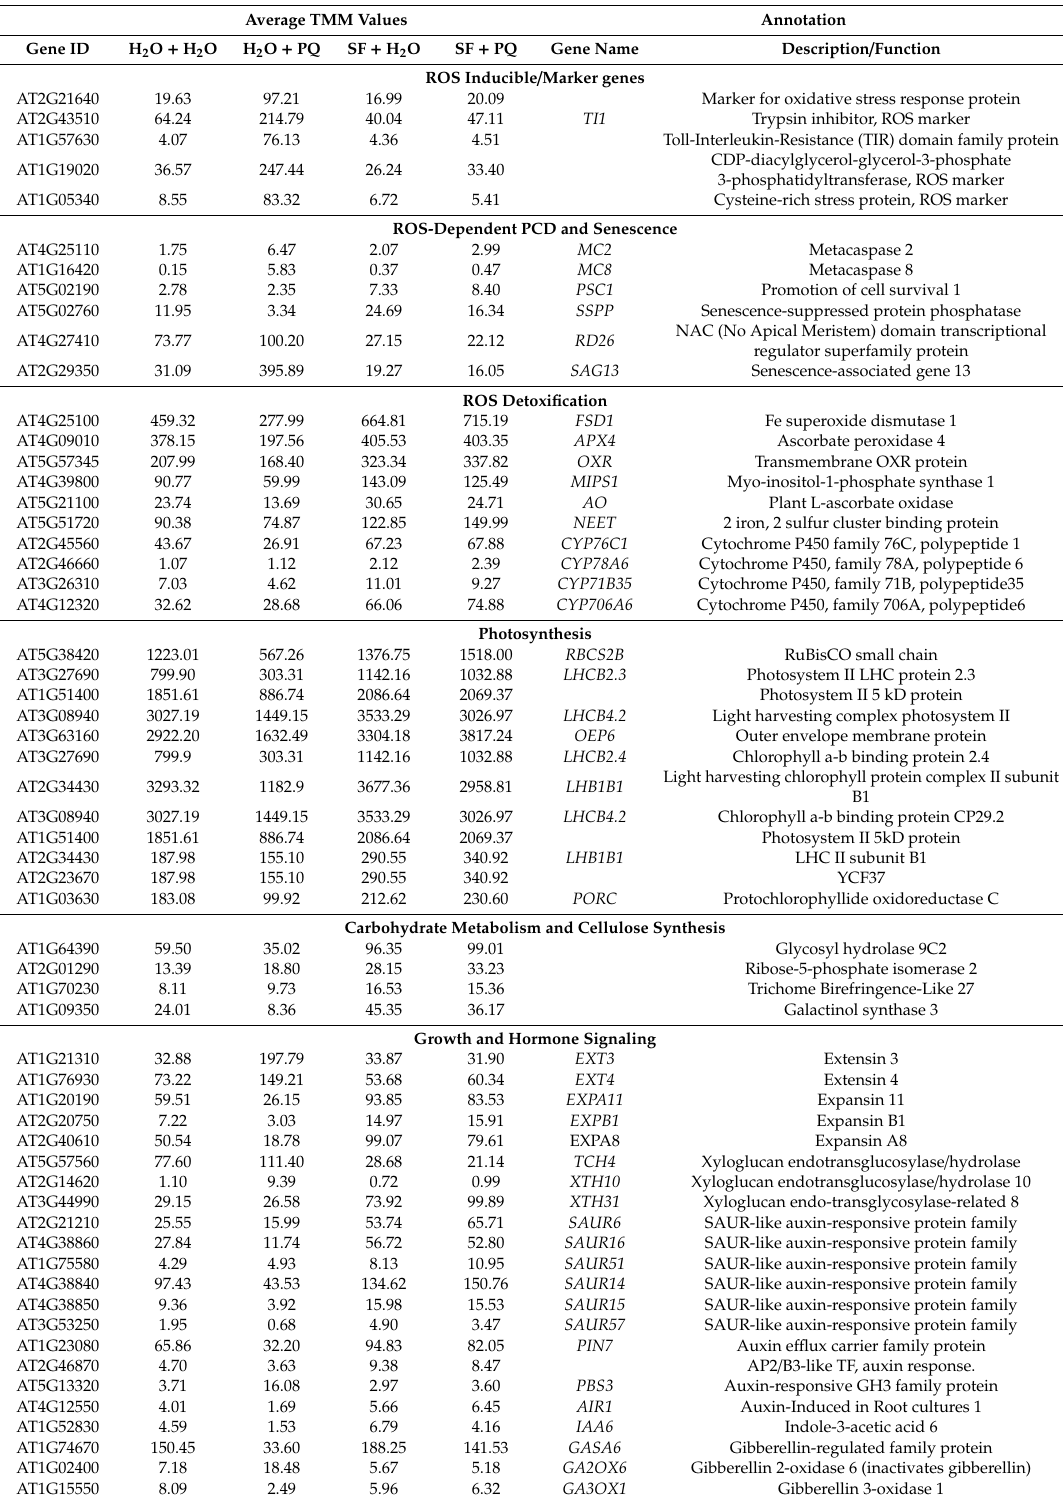
Table 1. SuperFifty and paraquat alter the expression of genes representing fundamental biochemical pathways and physiological processes. Values are TMM (trimmed mean of M-values) values averaged across three biological